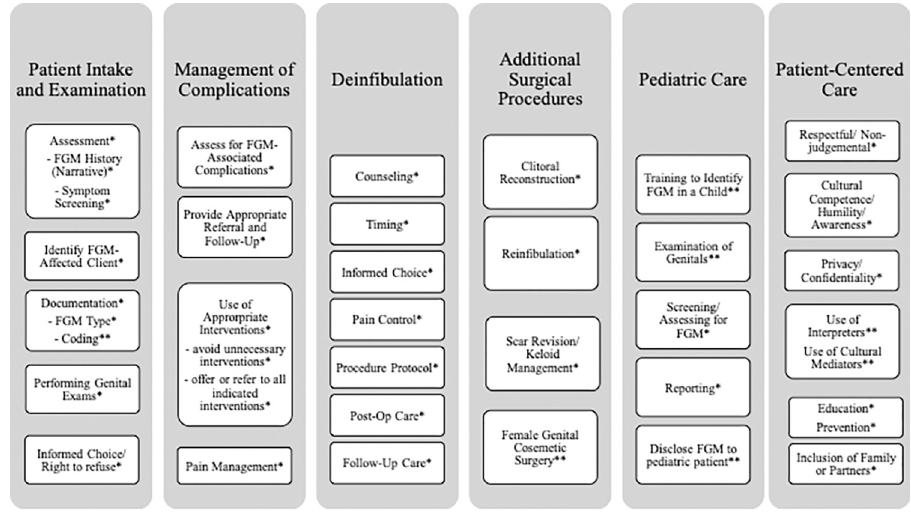
Fig 3. Practices: Categories and codes. * All Settings, ** Low Prevalence, *** High Prevalence.